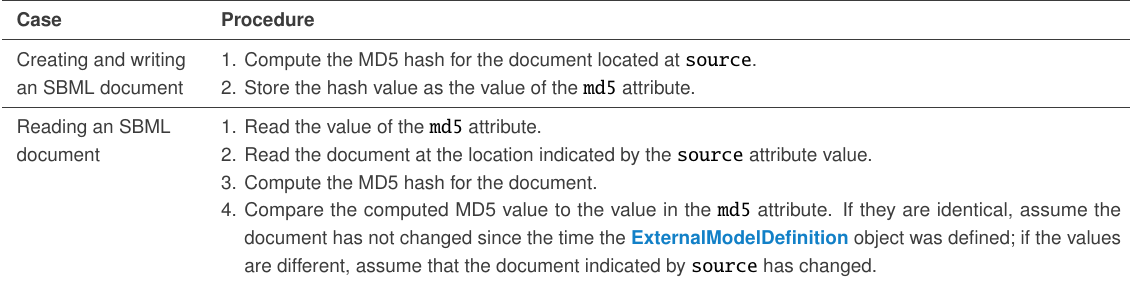
Table 2: Procedures for using the md5 attribute on ExternalModelDefinition